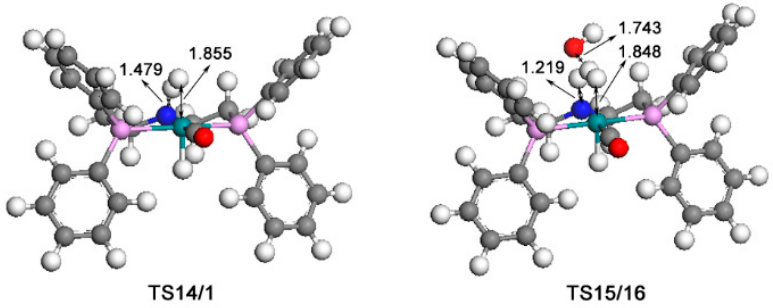
Figure 10. Optimized structures of TS14/1 (1151i cm − 1 ) and TS15/16 (806i cm − 1 ). The unit of bond lengths is expressed in angstrom (Å). (Green balls: Ru; pink: P; red: O; blue: N; grey: C; white: H).